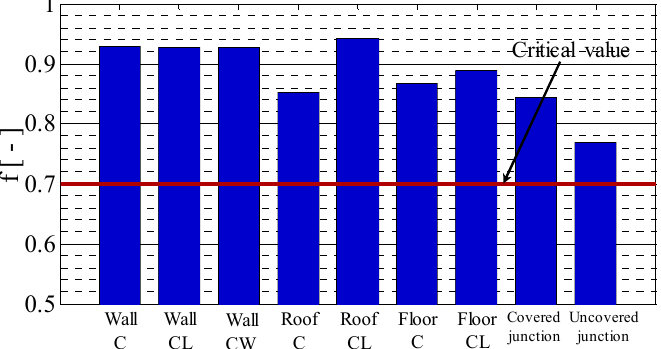
Figure 8. Temperature factors for the nine regions of the building envelope.